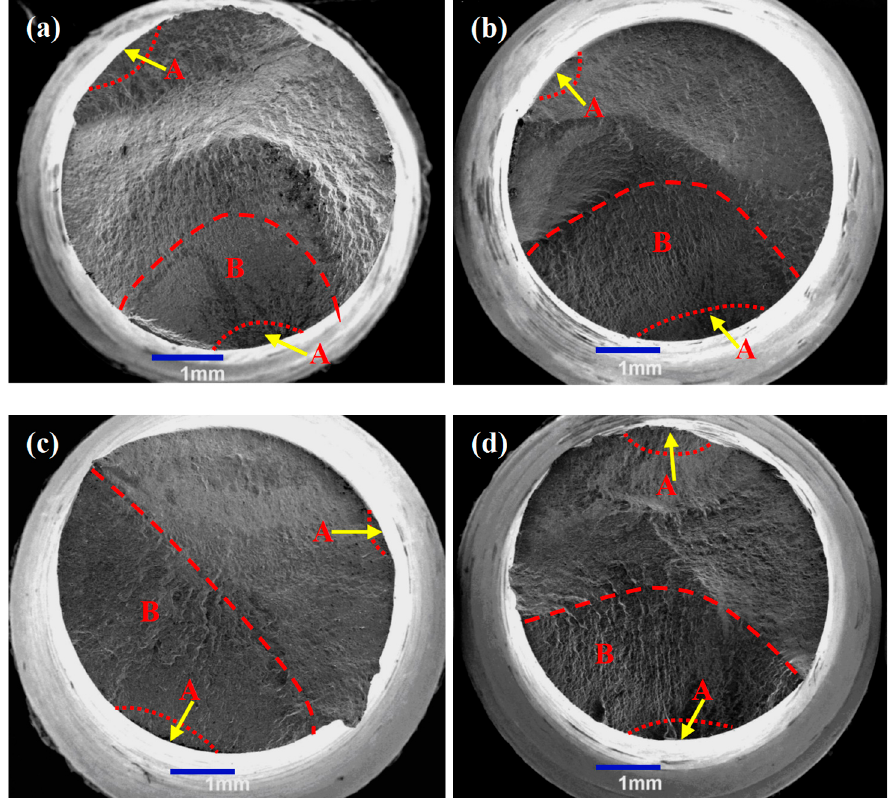
Figure 6. Macroscopic morphologies of fatigue fracture under proportional tension–torsion loading at different stress amplitudes. ( a ) S eq = 509.6 MPa, ( b ) S eq = 560.5 MPa, ( c ) S eq = 611.5 MPa, ( d ) S eq = 713.3 MPa. ‘A’ represents fatigue initiation zone and ‘B’ represents fatigue crack propagation zone.